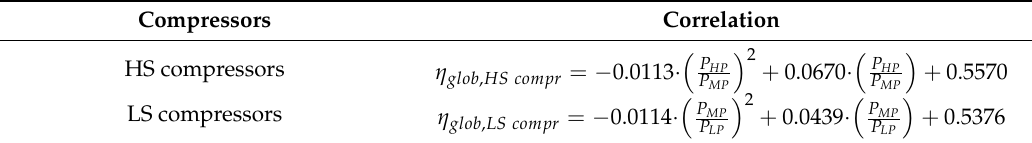
Table 5. Correlations used for assessing the performance of the compressors belonging to CB